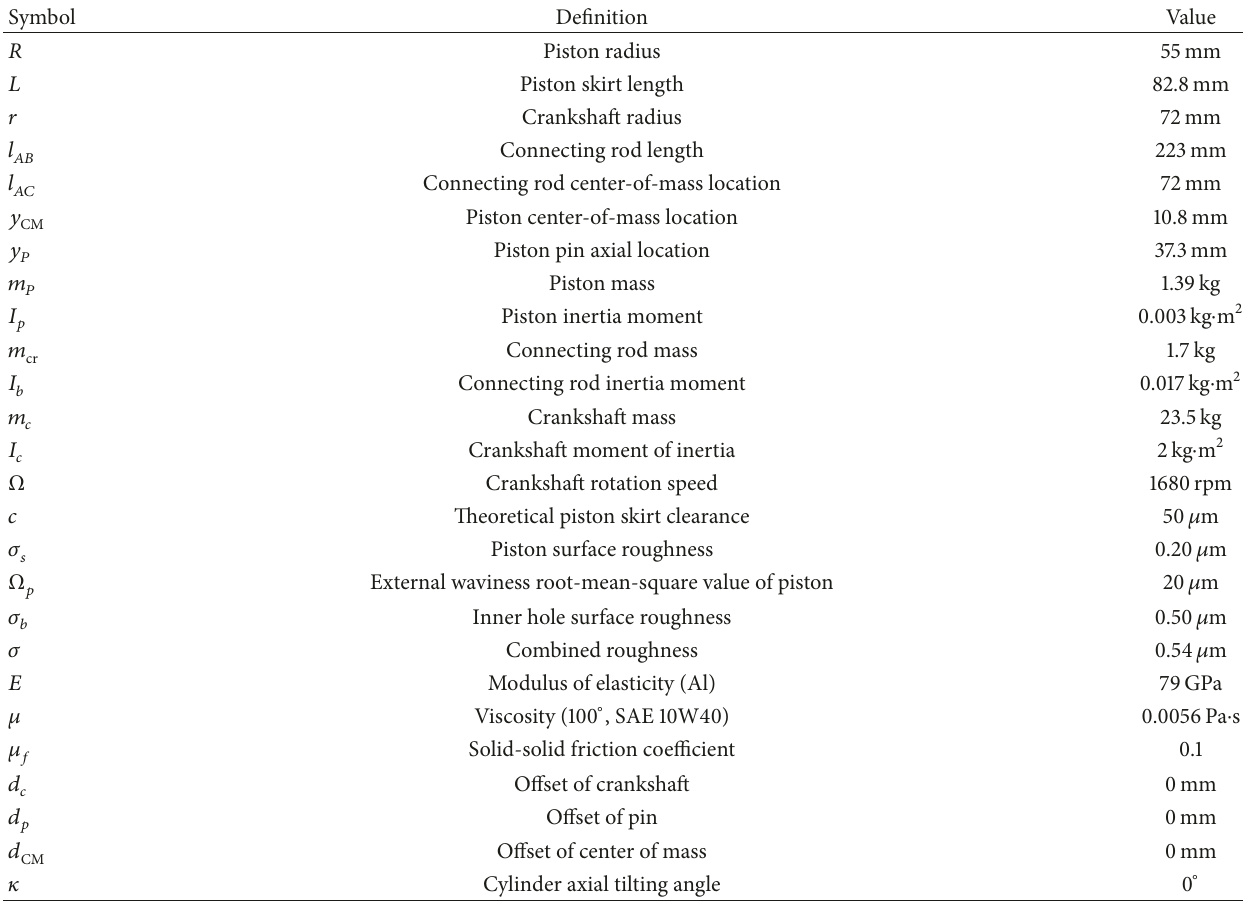
Table 2: Structure parameters of engine.